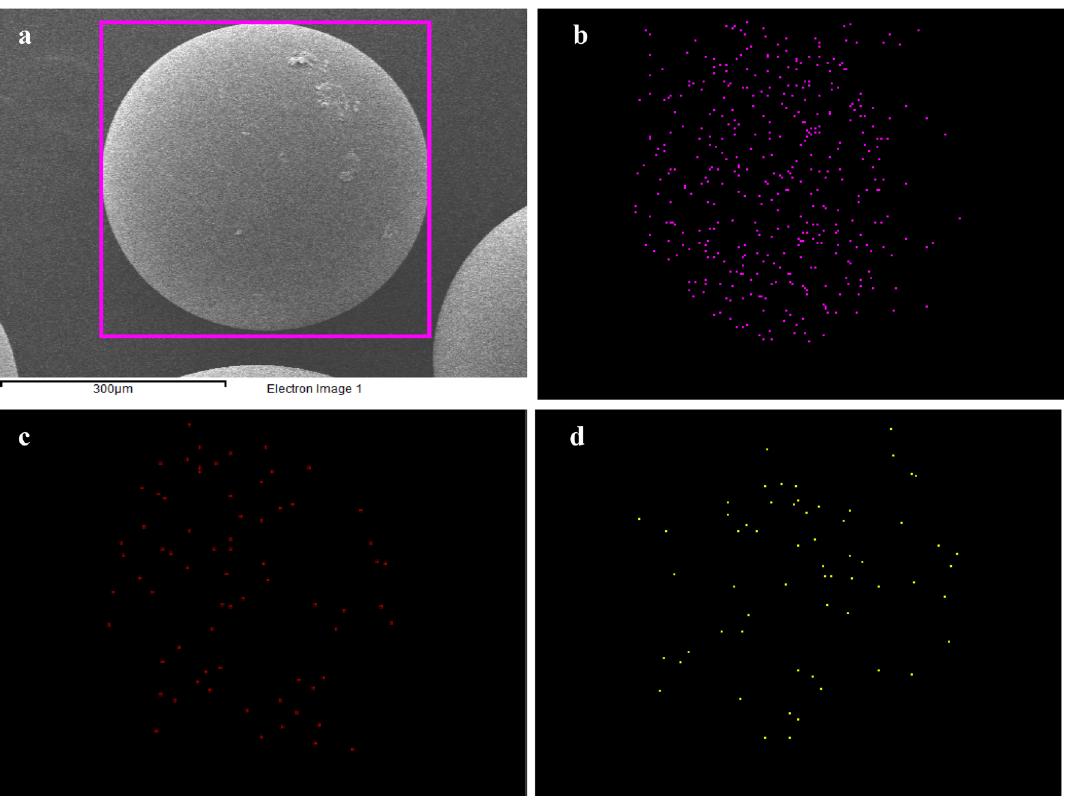
Figure 3. SEM pictures of the loaded SIR ( a ) and corresponding p ( b ), La ( c ) and Ce ( d ) elemental mappings.